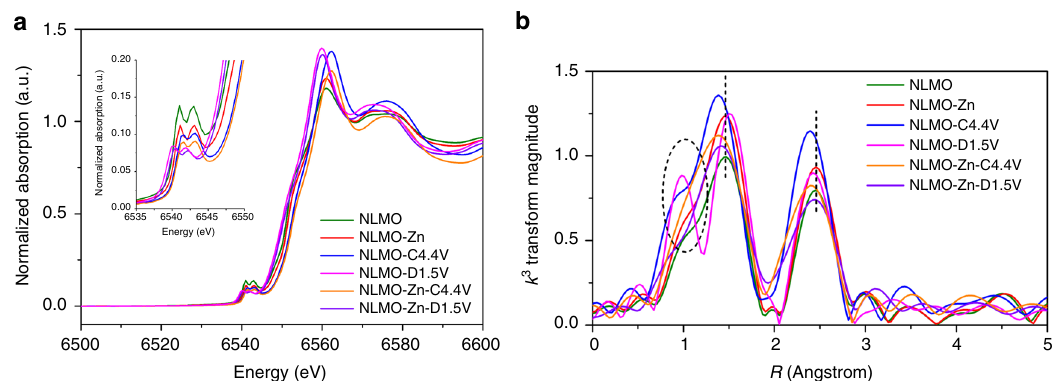
Fig. 5 Observation of Jahn – Teller distortion in NLMO and NLMO-Zn during the fi rst cycle. a Shows the XANES spectra at the Mn-K edge for NLMO and NLMO-Zn before cycling as well as in the fully charged and discharged states. b Shows Fourier-transformed (FT) magnitude of Mn K-edge EXAFS spectra for NLMO and NLMO-Zn before cycling as well as in the fully charged and discharged states